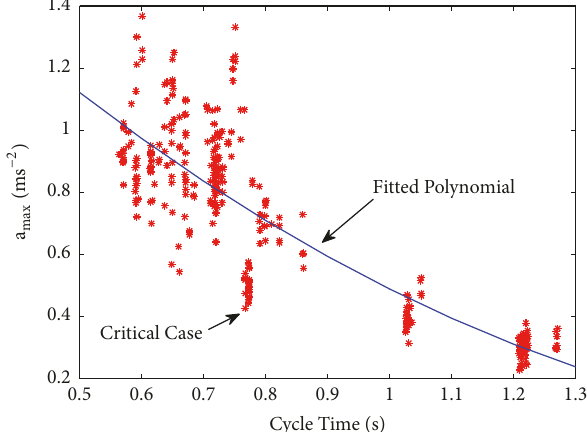
Figure 12: Scatter plot of the processed samples.